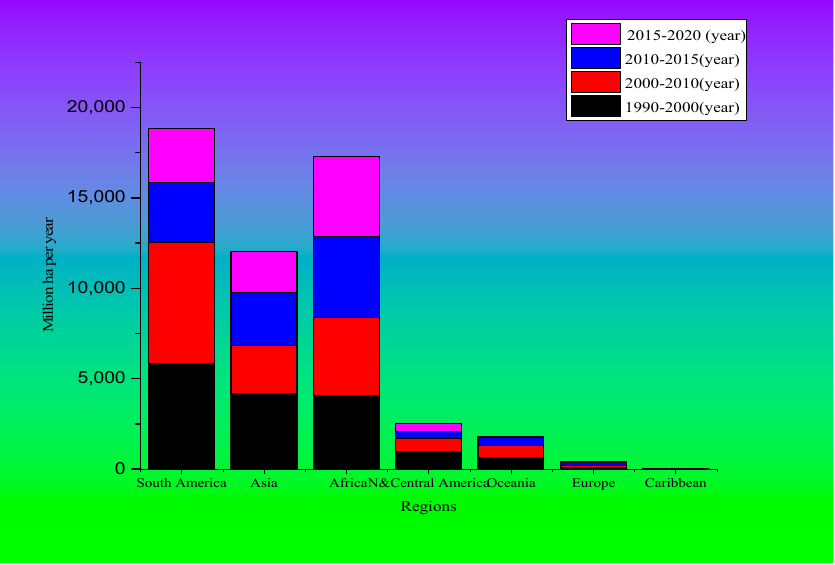
Figure 1. Deforestation rate, by region, for four periods spanning 1999–2000, Source: (FAO, 2020).